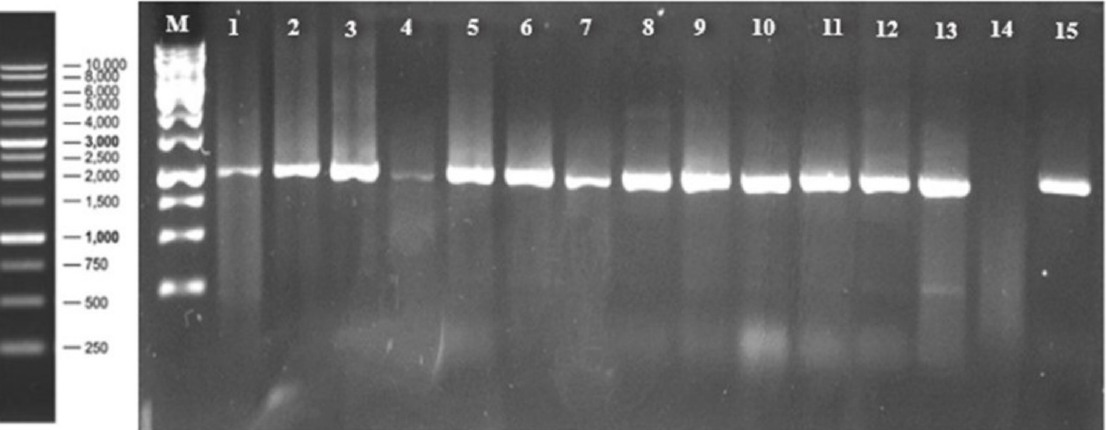
Figure 6. Gel electrophoreses (1%) showing positive RT-PCR amplification using F-3666- and R-4718-specific primers. (1052 bp) of ToBRFV from 13 tomato cultivars (lanes 1 to 13: tomato cultivars Dusmo, Seraj, Qurasema, Titanic, JV 15, Dafins, Baiknour, Jamilah, Tone Guitar, Newton, Mulla, Meghinha, Mawal, respectively); (M = 1 Kb DNA Ladder; Thermo Fisher Scientific, Waltham, MA, USA); (14 = negative control); (15 = positive